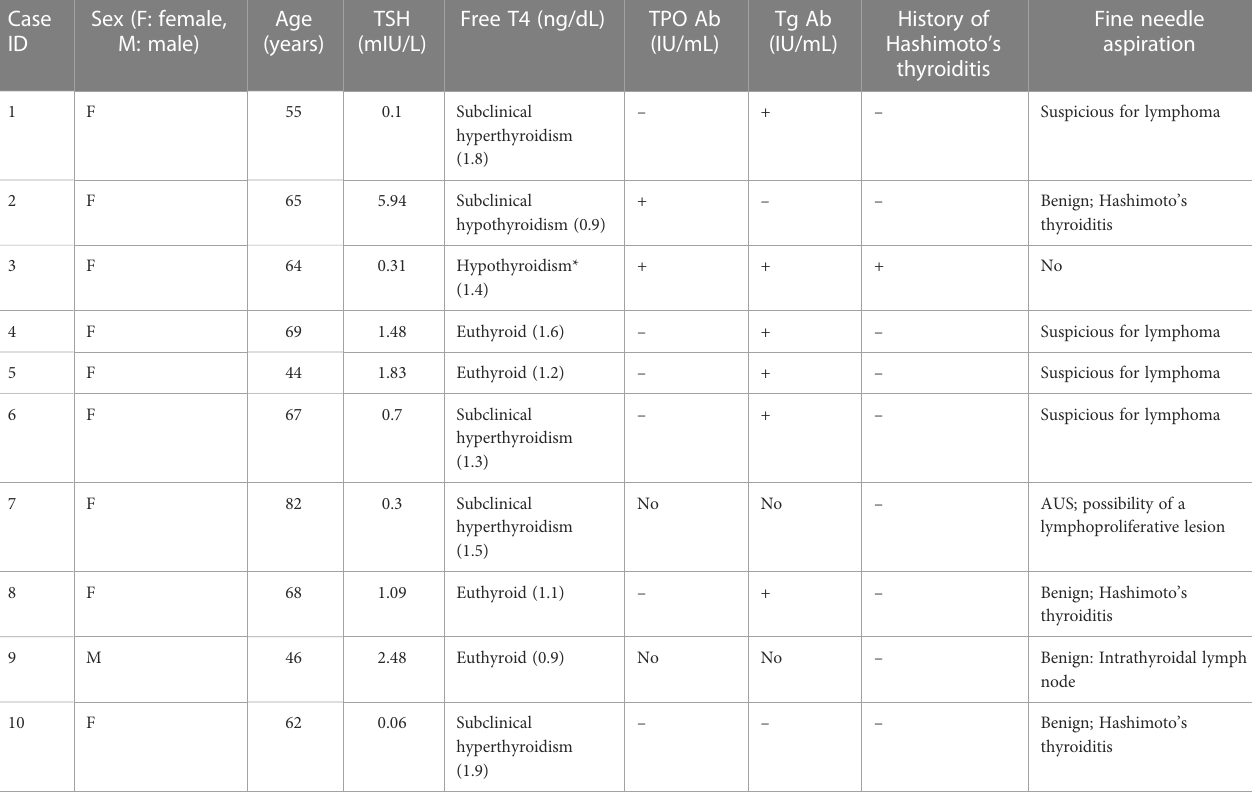
TABLE 1 Patient demographics, clinicopathologic features, and initial diagnosis. Case ID